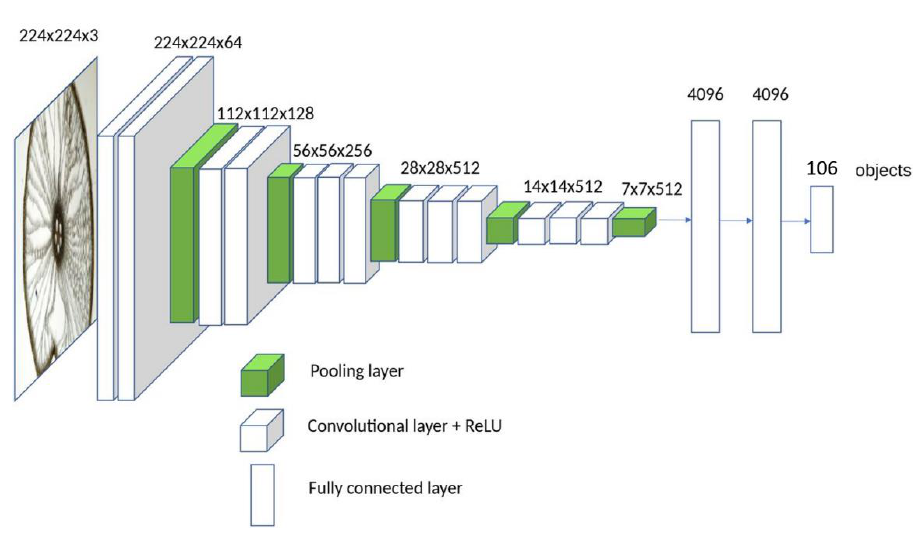
Figure 4. VGG-16 [33].